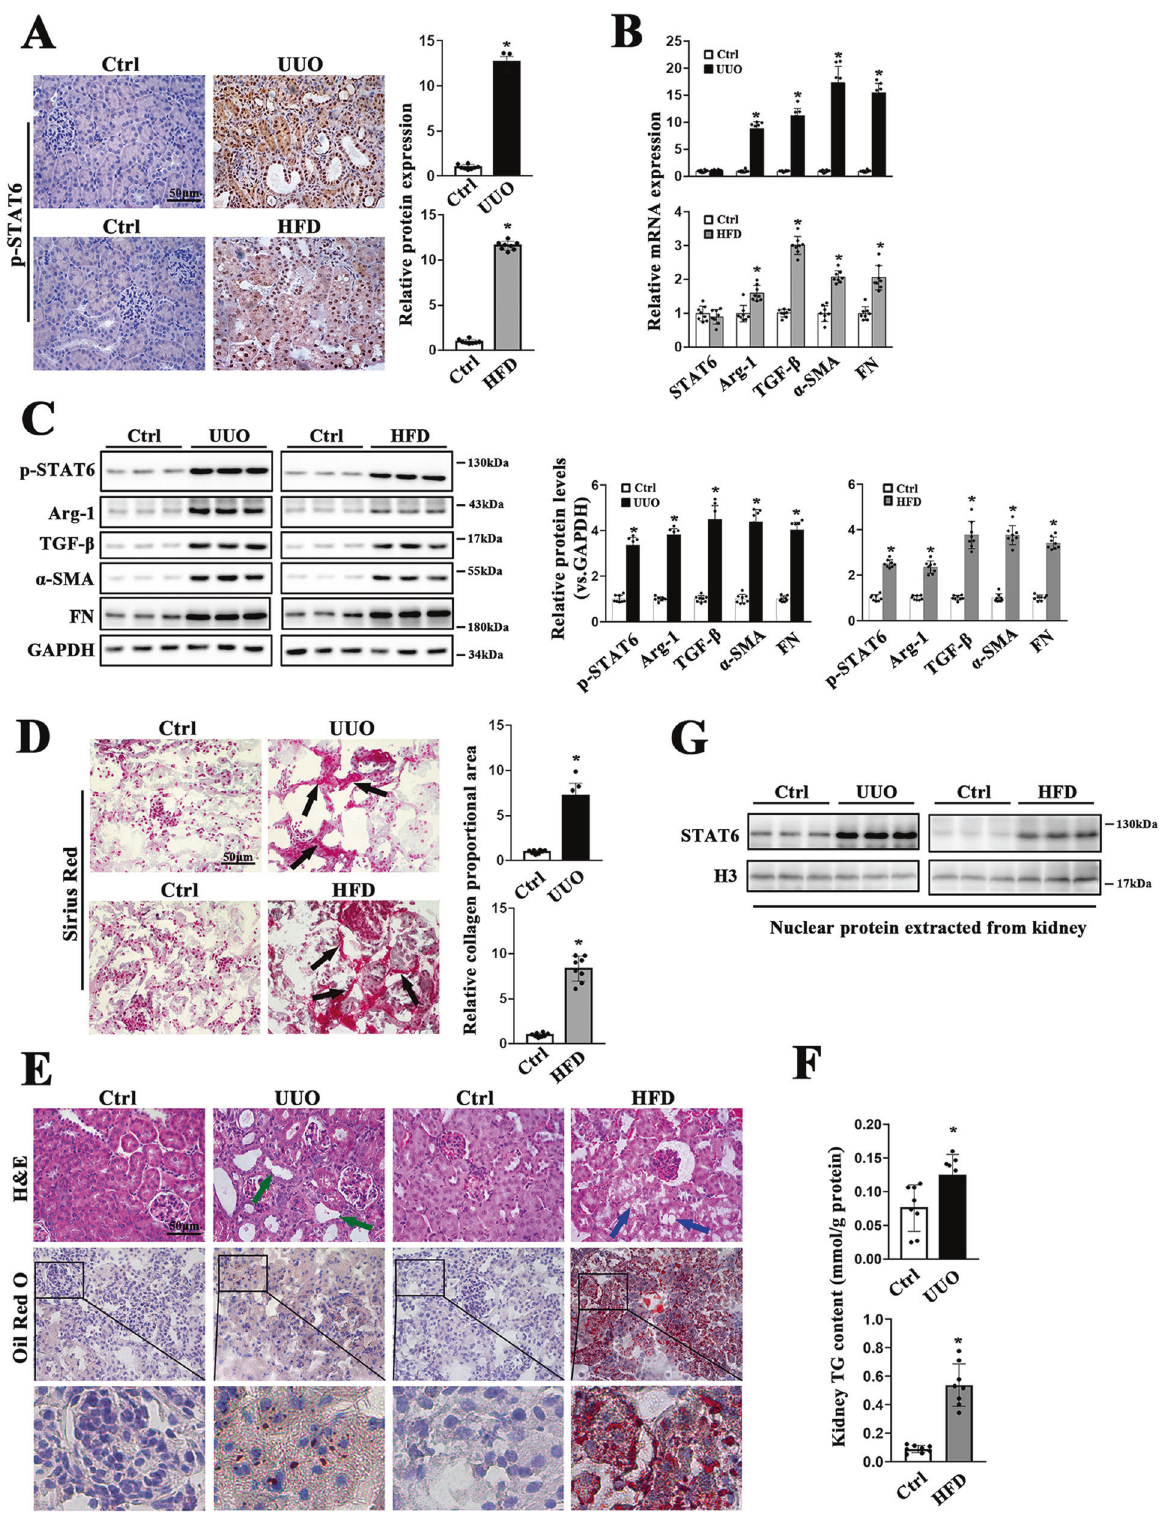
Fig. 1 STAT6 is activated in the kidneys of UUO and HFD mice. A Representative micrographs for IHC staining of p-STAT6 in kidney section and quanti fi cation are performed. B The mRNA and C protein expression of STAT6, p-STAT6, Arg-1, TGF- β , α -SMA, FN in the indicated groups were determined by qRT-PCR or immunoblot analyses with the quanti fi cation on the right panel. D Representative micrographs for Sirius red and relative collagen proportion was quanti fi ed. E Representative micrographs for H&E and Oil Red O staining in kidney sections from indicated group. F Kidney TG content were measured in the indicated groups. Results are expressed as the mean ± SD ( n = 8, * p < 0.05, Ctrl vs . Treatments). G Nuclear proteins were extracted from kidneys from different individuals as indicated, STAT6 and H3 were assayed by western blot